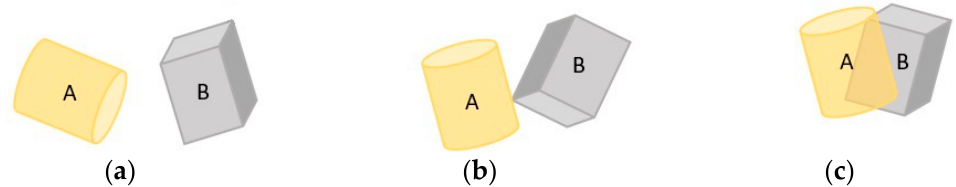
Figure A1. A phi-function differentiates three cases of mutual arrangements of a pair of objects: ( a ) no common points; ( b ) common boundary points only; ( c ) common interior points.